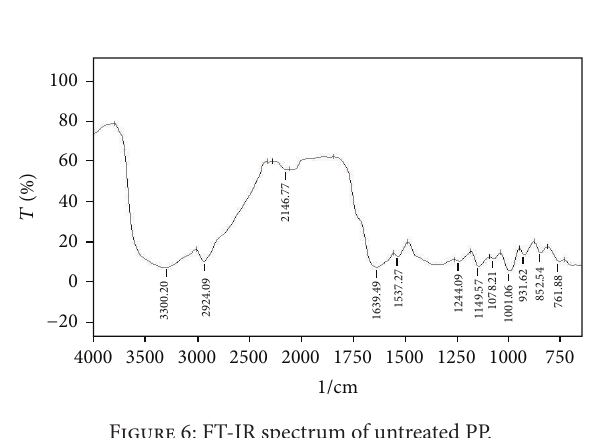
Figure 4: FT-IR spectrum of untreated GL after adsorption of BG.